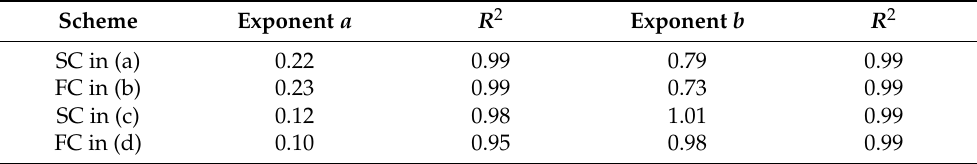
Figure 5. Spinodal wavelength ( a , c ) and peak intensity ( b , d ) as a function of the aging time (the straight lines are power-law fits from linear regression). Table 5. Power-law exponents a and b , and linear regression coefficients 𝑅 (cid:2870) , from fitting.